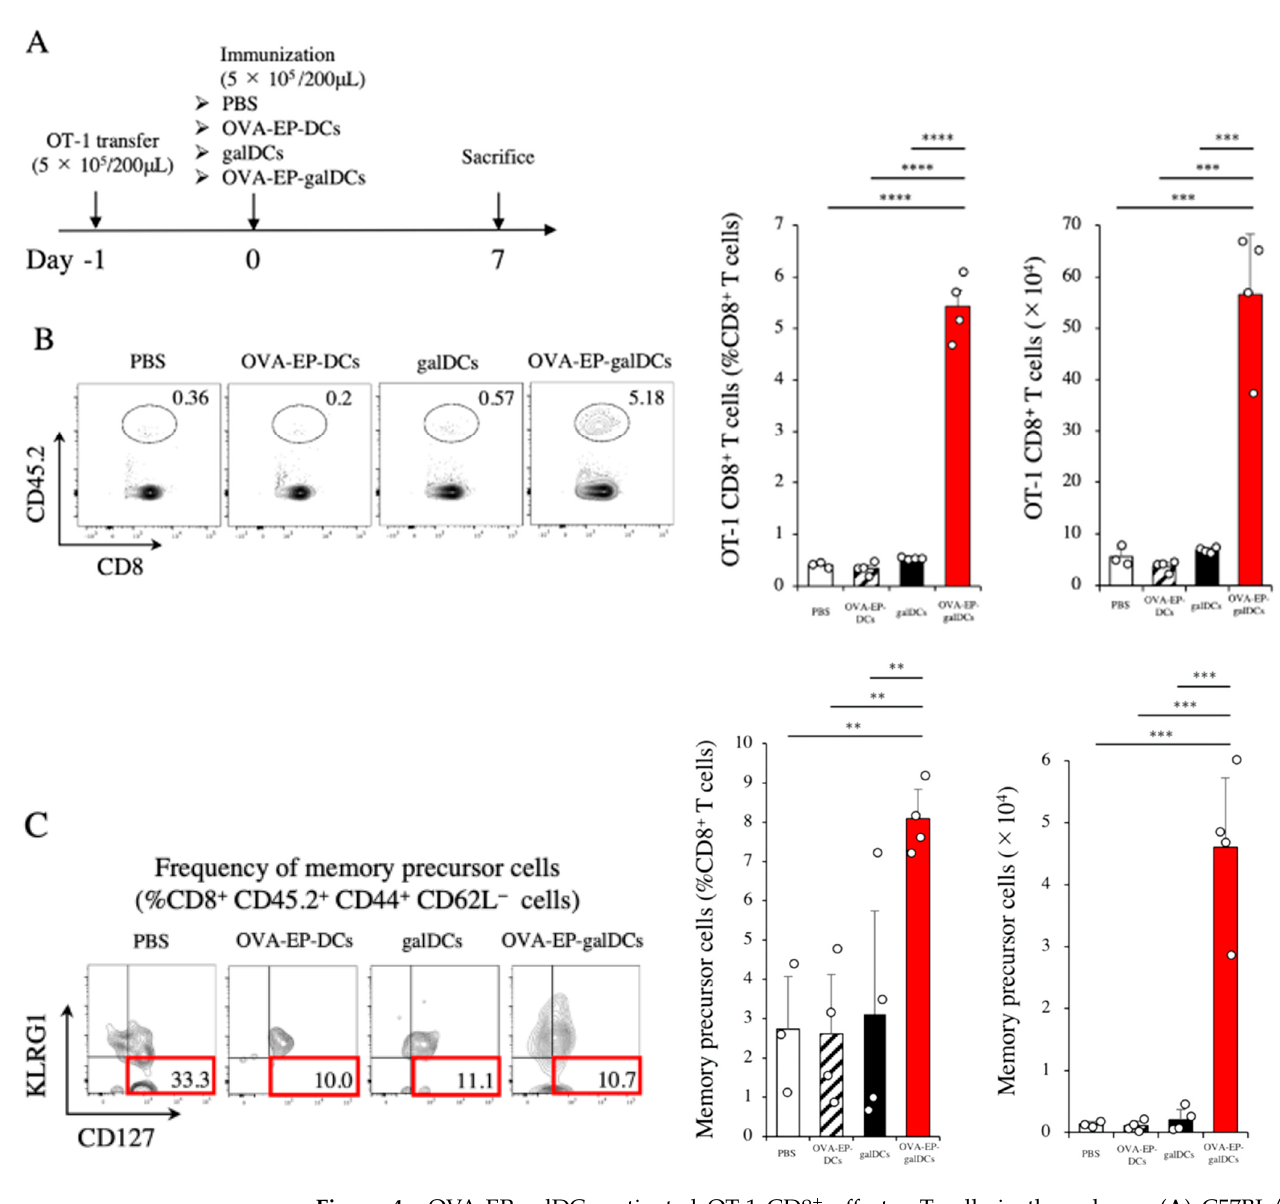
Figure 4. OVA-EP-galDCs activated OT-1 CD8 + effector T cells in the spleen. ( A ) C57BL/6-background CD45.1 + congenic mice were transferred with 5 × 10 5 CD45.2 + OT-1 CD8 + T cells (day − 1), and one day later were immunized with PBS, OVA-EP-DCs, galDCs, or OVA-EP-galDCs (5 × 10 5 cells/mouse). On day 7, OT-1 CD8 + T cells (CD45.2 + CD8 + T cells) and memory precursor cells (CD44 + CD62L − KLRG1 − CD127 + CD45.2 + CD8 + T cells) in the spleen were assessed by flow cytometry. ( B ) Typical examples of flow cytometric analysis, the frequency, and the number of OT-1 CD8 + T cells in the spleen are shown ( n = 3,4). ( C ) Typical examples of flow cytometric analysis, the frequency, and the number of memory precursor cells in the spleen are shown ( n = 3,4). To analyze statistical differences among multiple groups, ANOVA with Holm’s post hoc test was